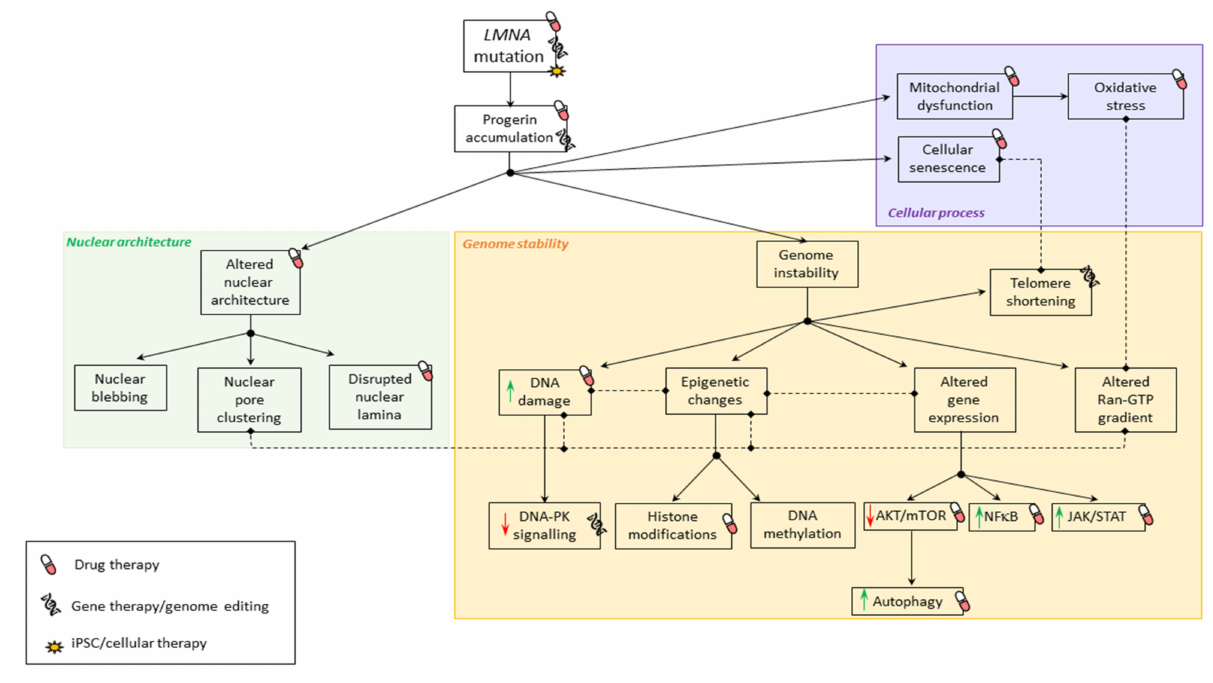
Figure 2. Pathophysiological mechanisms involved in premature aging syndromes. Summary of physiological mechanisms affected in premature aging syndromes due to LMNA mutations. Black solid arrows indicate the consequence of altered mechanisms. Doted lines indicate correlation between